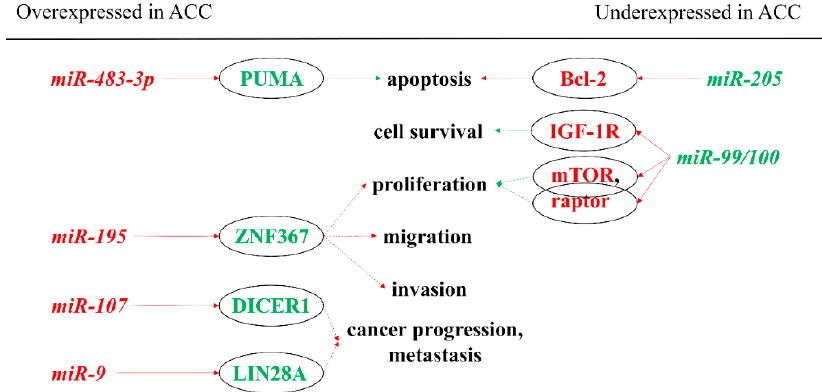
Figure 1. miRNAs showing oncogenic and tumor suppressor actions in the pathogenesis of ACC by targeting mRNAs. Red indicates inhibition, whereas green indicates stimulation. A solid arrow indicates a direct relationship, a dotted arrow indicates an indirect relationship. Red letters indicate oncogenic function; green letters indicate tumor suppressor function. ACC: adrenocortical cancer; Bcl-2: B-cell lymphoma 2; IGF-1R: insulin-like growth factor 1—receptor; miR: microRNA; mTOR: mammalian target of rapamycin; PUMA: p53 upregulated modulator of apoptosis; ZNF367: zinc finger protein 367.